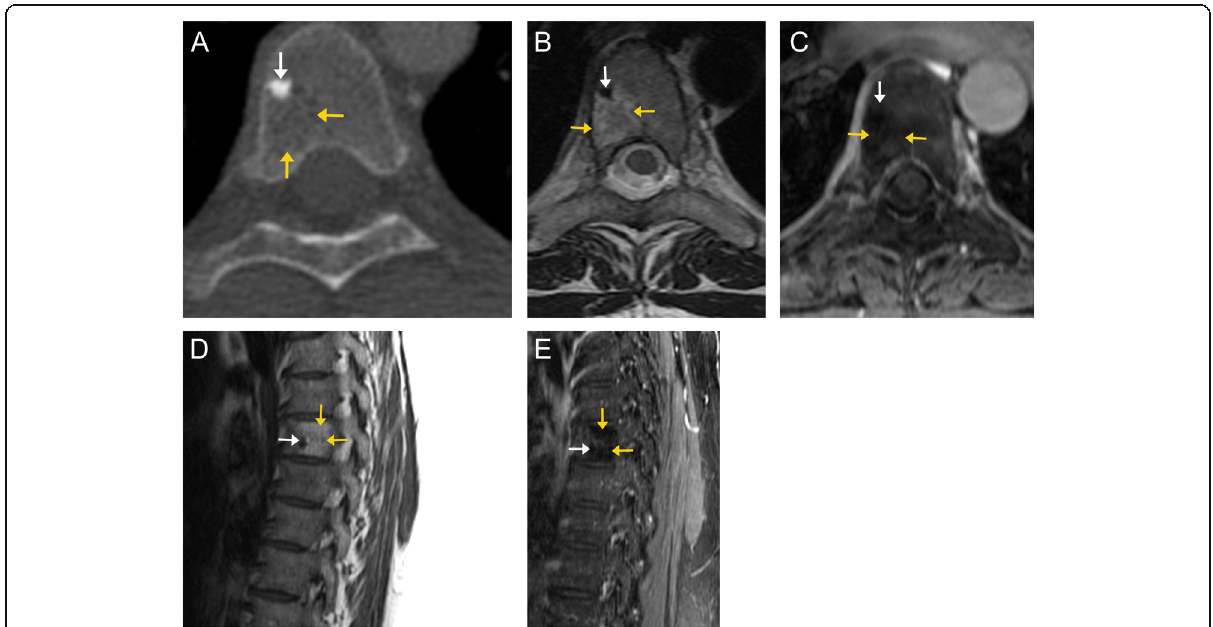
Fig. 5 Enostosis with adjacent vertebral vascular malformation. Axial CT image of the spine ( a ) demonstrates the enostosis as a sclerotic bone lesion (white arrow). MRI shows low signal intensity like cortical bone; hypointensity on T1- ( d , white arrow) and T2- ( b , white arrow) weighted images, without enhancement post contrast ( c , e ). There is an adjacent ill-defined lesion with lucencies and intervening thickened trabeculae ( a , orange arrows). This lesion demonstrates T1/T2 hyperintense signal ( b , d , orange arrows), fat suppression ( c , e , orange arrows) and no enhancement post contrast ( c , e , orange arrow). This lesion is consistent with a vertebral venous vascular malformation (formerly known as a